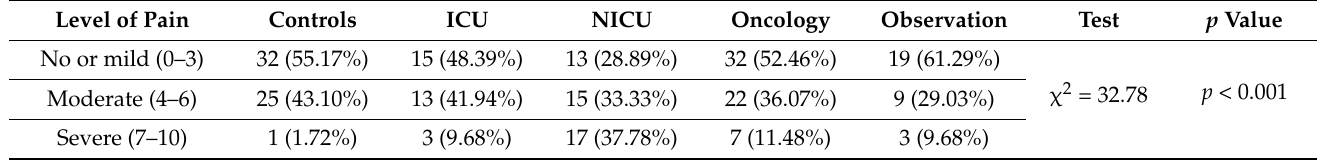
Table 5. A comparison of groups distinguished according to the place of hospitalization of the child with respect to the severity of maximum pain. Level of Pain Controls ICU NICU Oncology Observation Test p